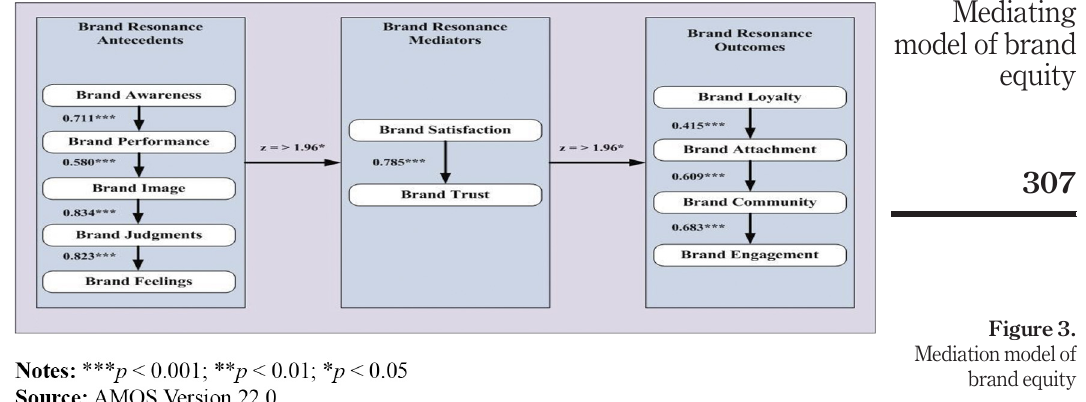
Figure 3. Mediation model